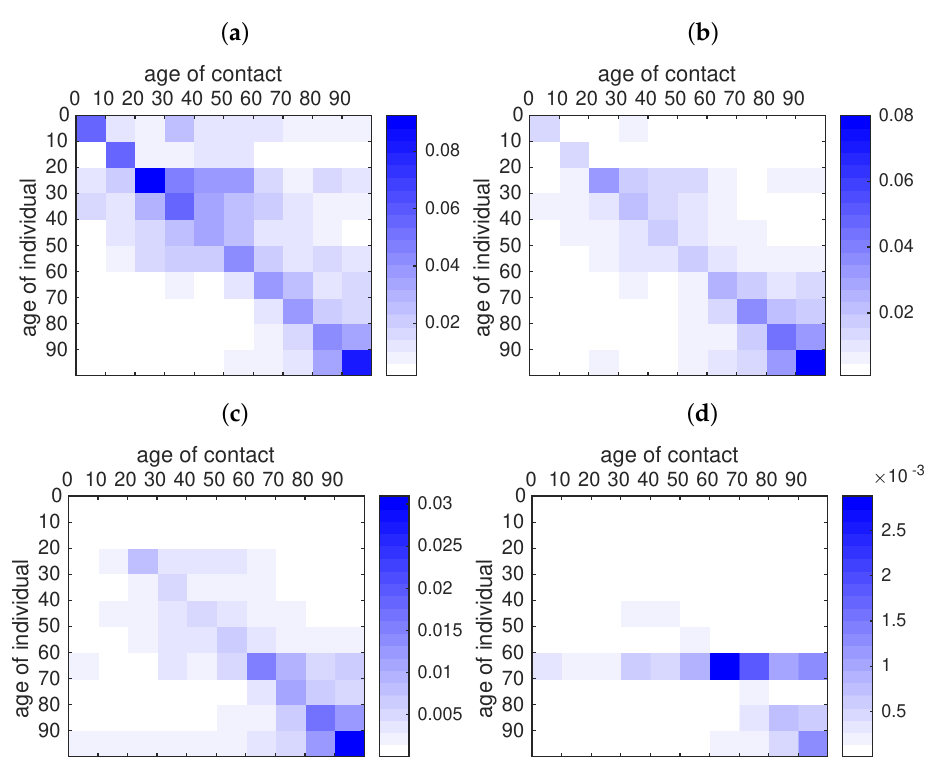
Figure 13. Rate of contact between age classes according to the fitted data. For each age class in the y -axis we plot the rate of contacts between one individual of this age class and another individual of the age class indicated on the x -axis. ( a ) is the rate of contacts before the start of public measures (11 April). ( b ) is the rate of contacts at the date of effect of the public measures for the last age class (16 April). ( c ) is the rate of contacts one week later (23 April). ( d ) is the rate of contacts one month later (16 May). In this figure we use τ 1 = 0.1630, τ 2 = 0.1224, τ 3 = 0.3028, τ 4 = 0.2250, τ 5 = 0.1520, τ 6 =